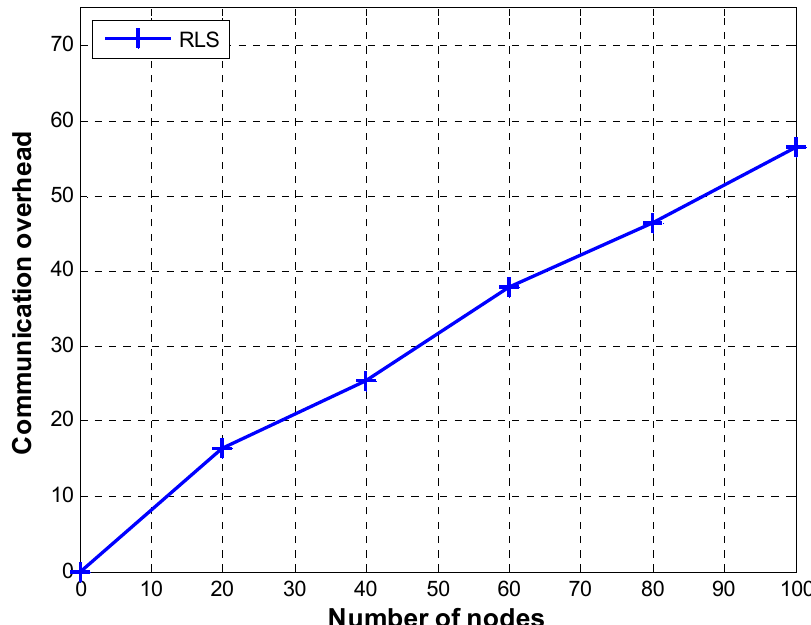
Figure 2. Communication overhead of Reverse Localization Scheme (RLS).